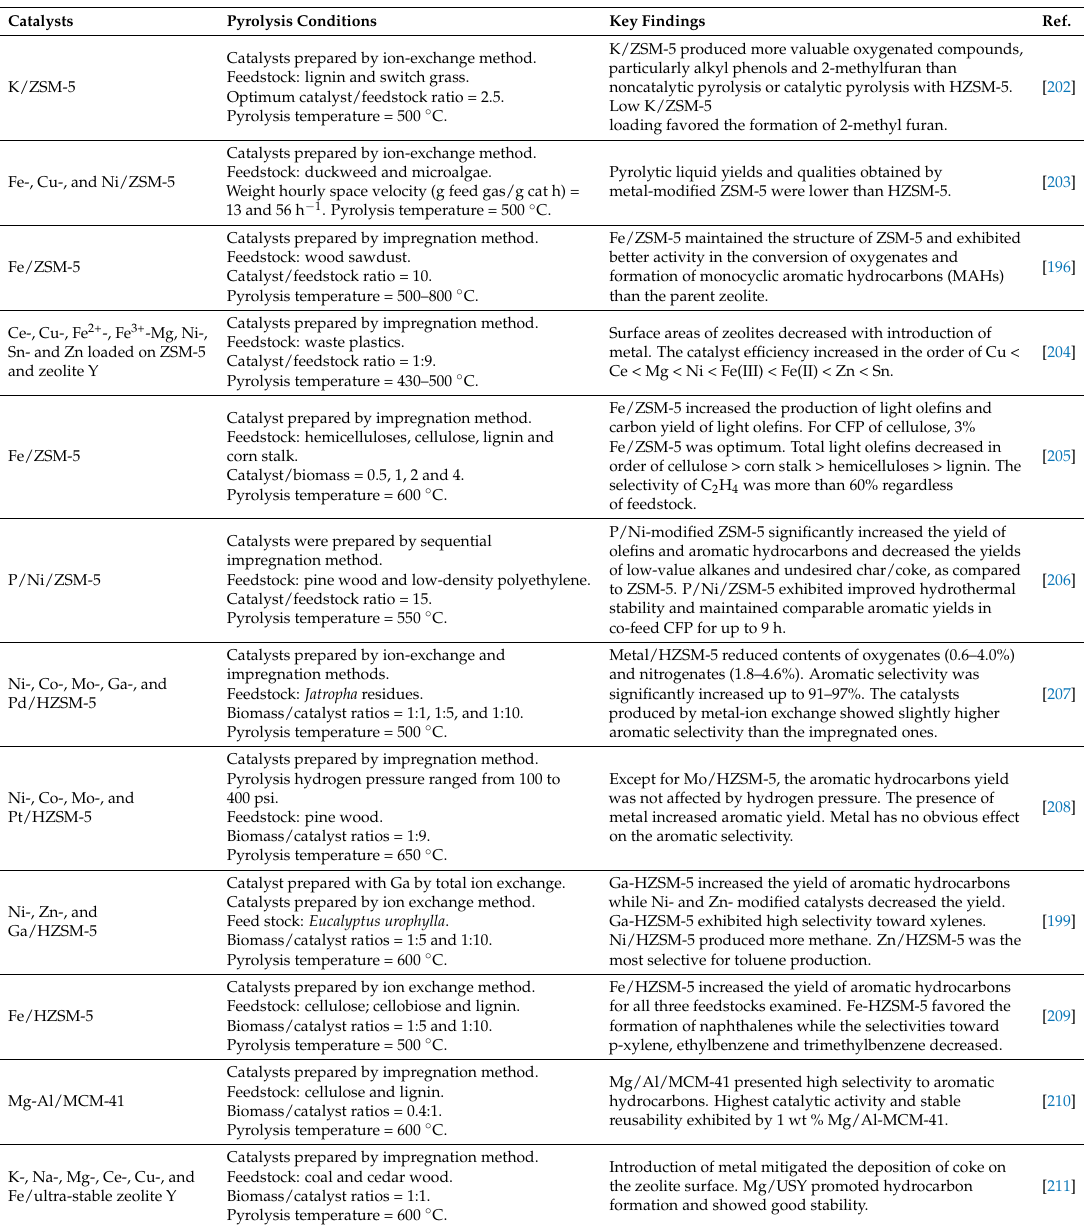
Table 2. Metal doped zeolite used for in-bed